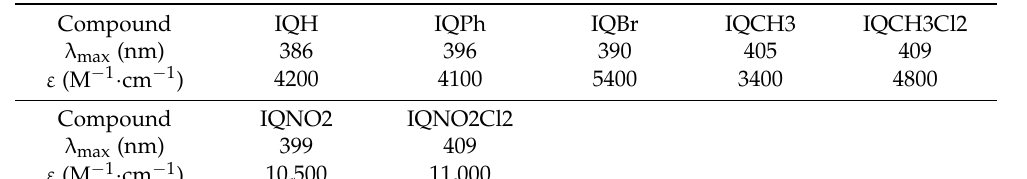
Table 2. Absorption maxima of different quinoxaline dyes in ethyl acetate.